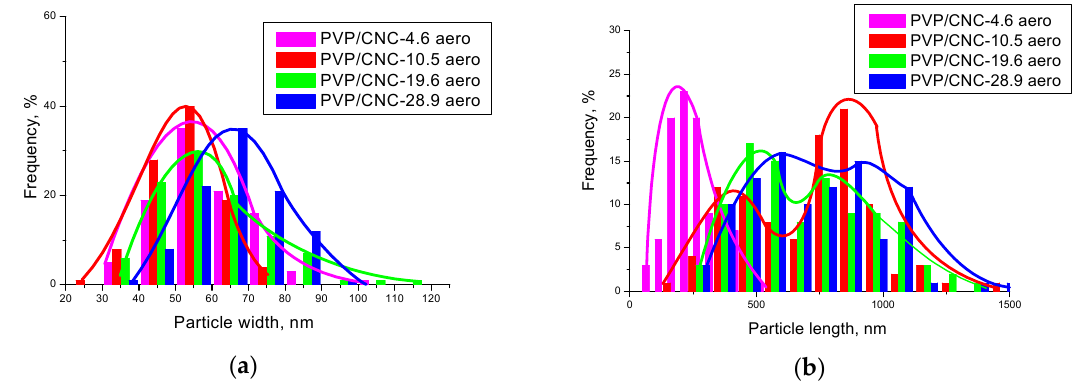
Figure 10. The CNC particle size distribution in the composite aerogels across the widths ( a ) and along the lengths ( b ).